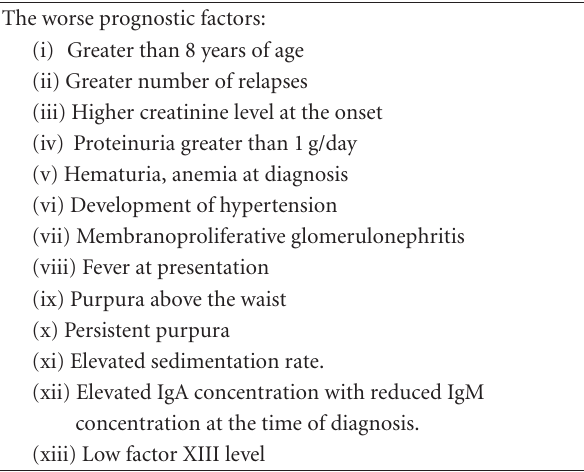
Table 4: Prognostic factors for HSP: [1, 2, 19–22]. The worse prognostic